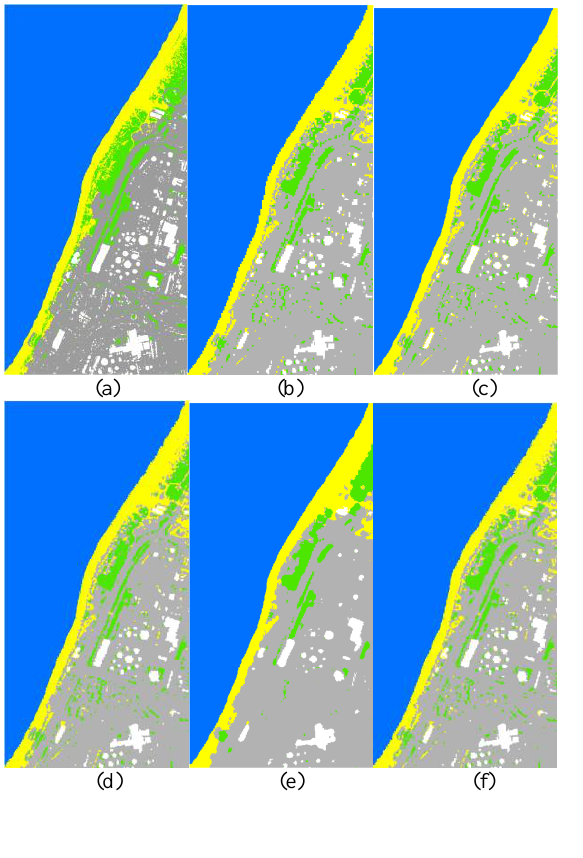
Table 3. Accuracy of post-processed